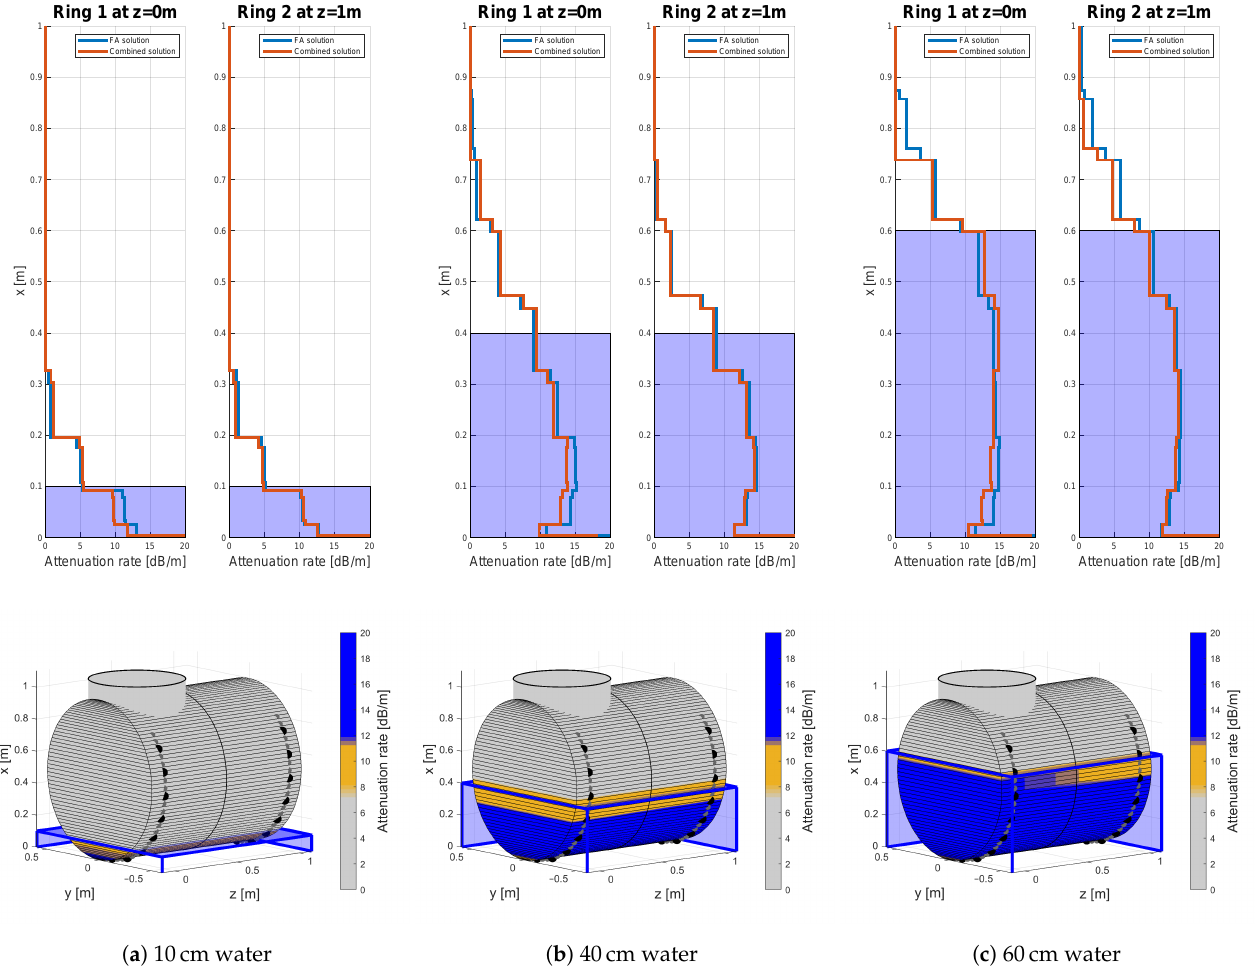
Figure 8. Results for various solely water fillings for 100kHz excitation frequency and 15cm sensor